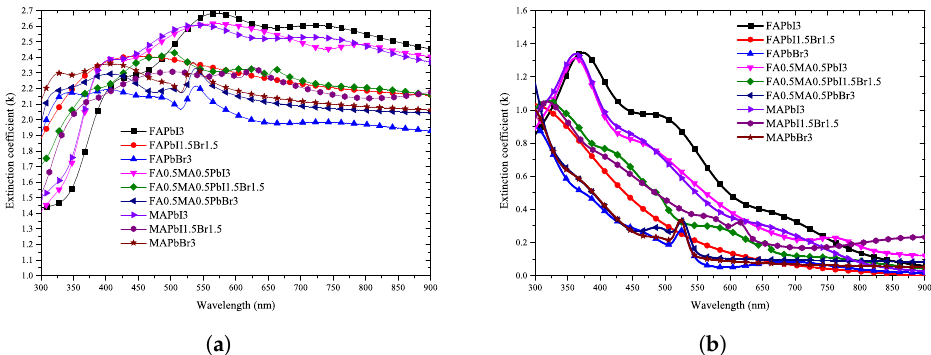
Figure 6. Analysis of optical properties through ellipsometry analysis of quaternary perovskite materials: ( a ) refractive index, ( b ) extinction coefficient.